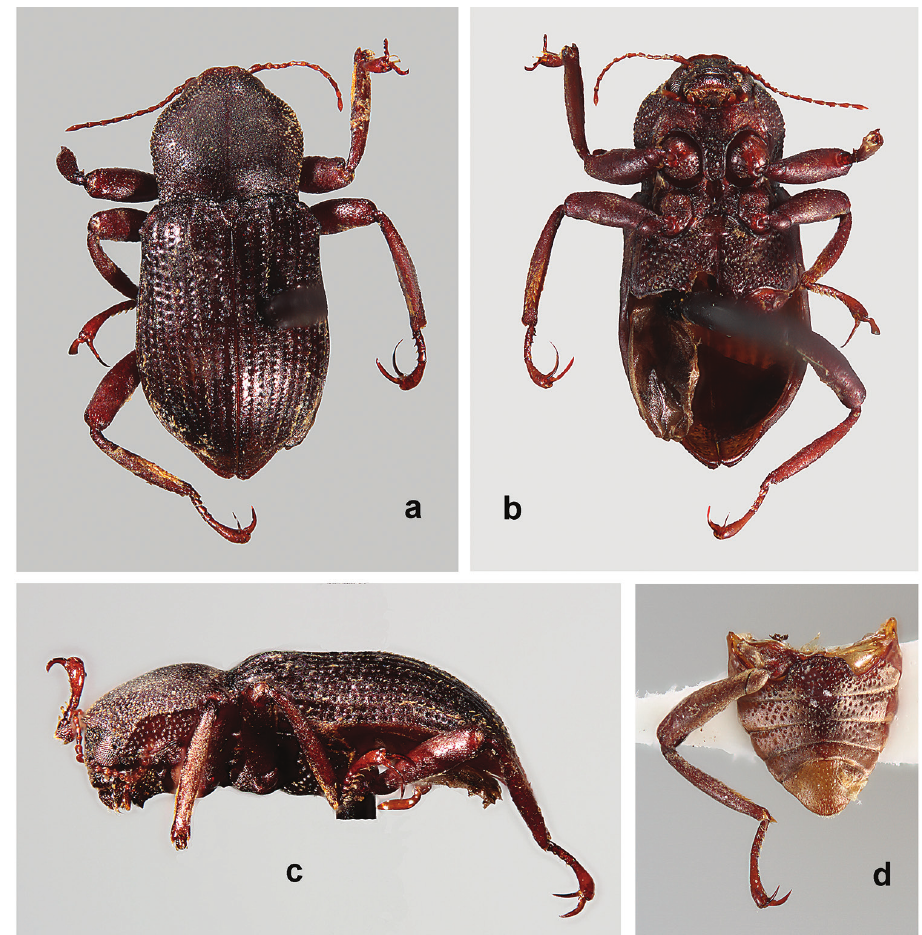
Figure 9. Amazonopsis camachoi sp. n., holotype male, length 4.70 mm a Dorsal habitus b Ventral habi- tus, lacking abdomen and right metathoracic leg c Lateral habitus, lacking abdomen d Ventral habitus of abdomen and right metathoracic